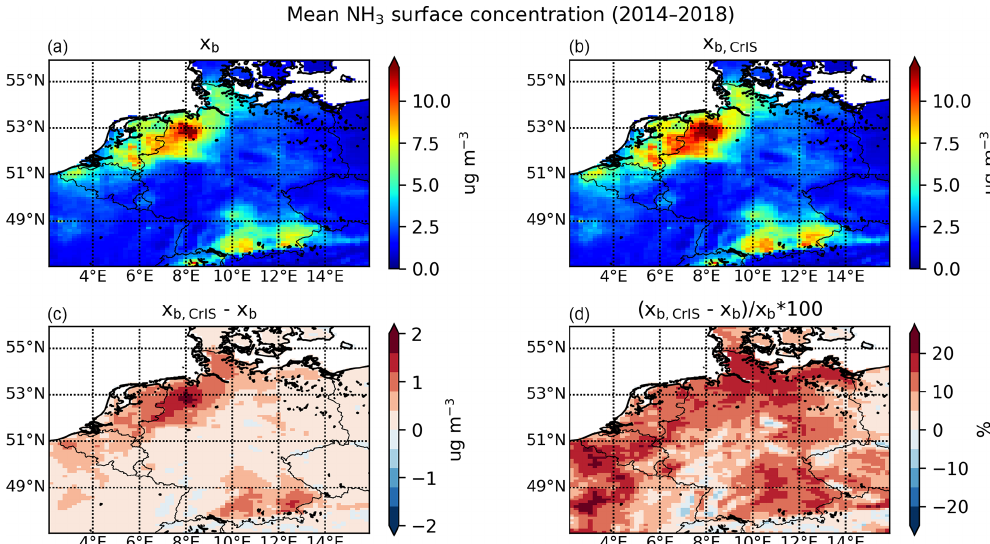
Figure 4. The mean NH 3 surface concentration over 2014 to 2018 from the (a) default background run ( x b ) and the (b) background run with CrIS-based NH 3 time factors ( x b , CrIS ) and their (c) absolute and (d) relative difference.